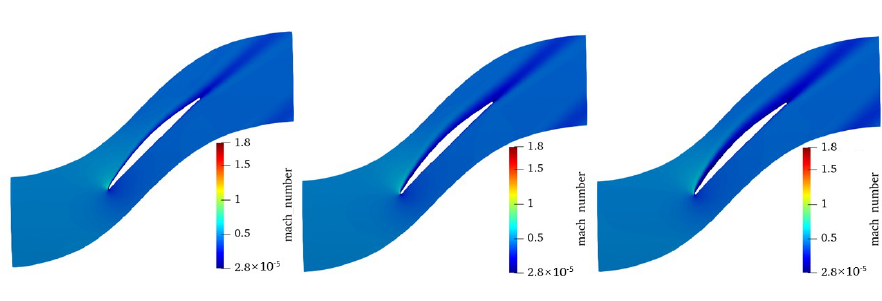
Figure 17. The profiles of the baseline, sample_W, and sample_B.